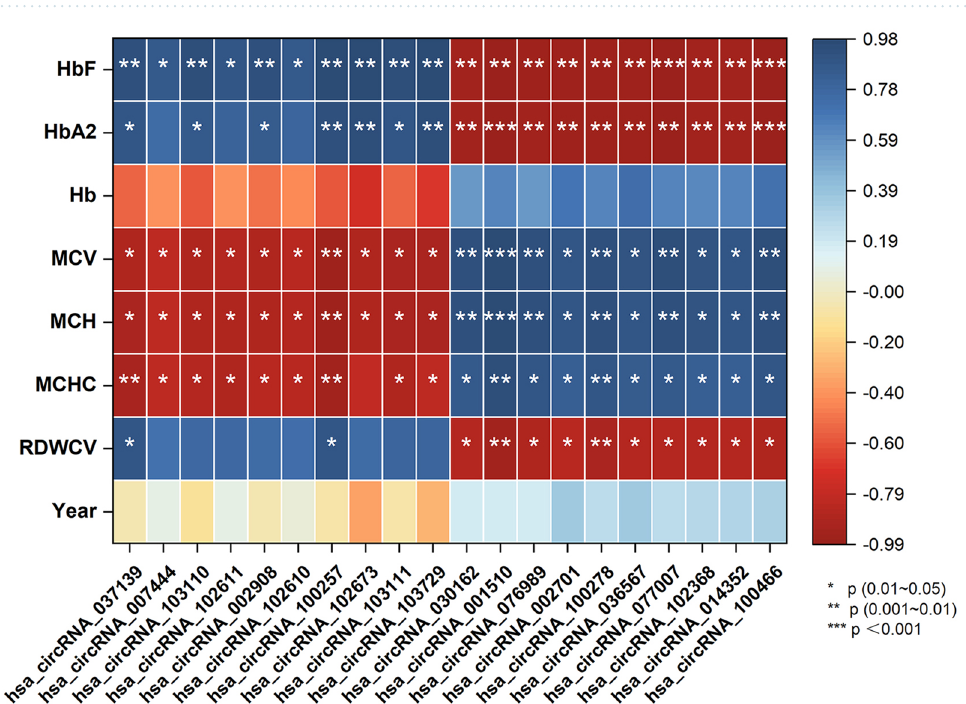
Figure 2. Heatmap showing the correlation between circRNAs expression and hematologic parameters. The top 10 essential nodes ranked by MCC scores were determined by CytoHubba